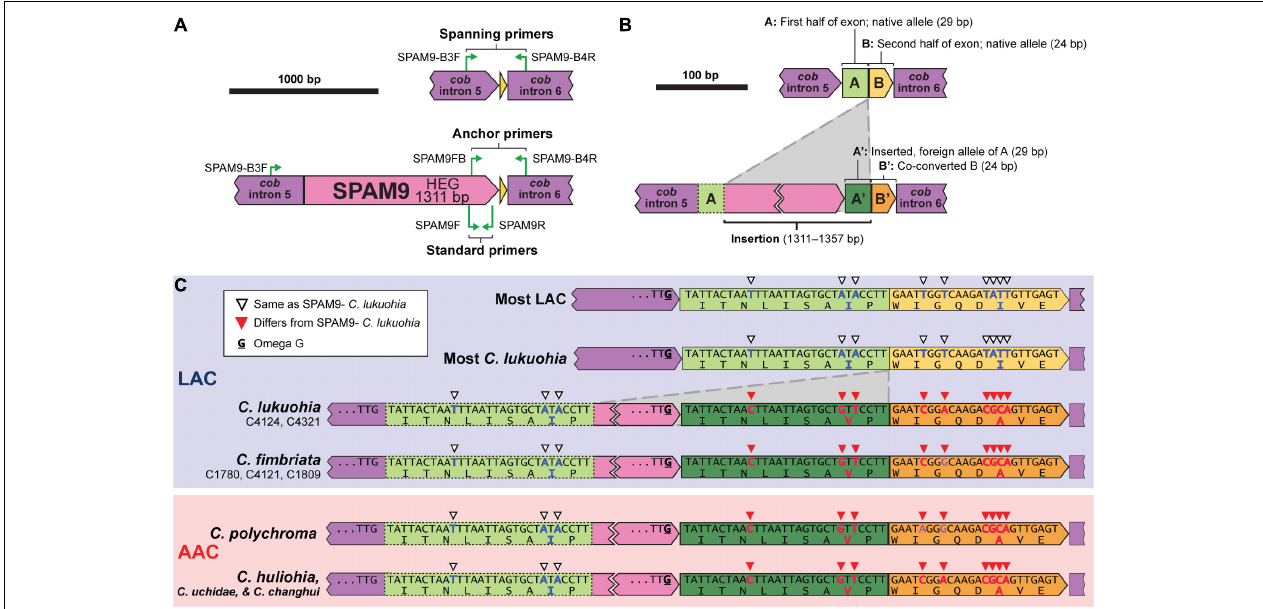
FIGURE 6 | Location, insertion, and co-conversion of SPAM9. (A) Proposed arrangements of SPAM9-negative (top) and SPAM9-positive (bottom) alleles of cob in C. lukuohia . (B) Proposed insertion scheme for SPAM9. The cob exon is split by the insertion into two regions: “A,” 29 bp, and “B,” 24 bp. SPAM9 is an autonomous homing endonuclease with a slightly different copy of A (A (cid:48) ) on its 3 (cid:48) end; it inserts in the middle of the exon, splitting A and B, and in doing so co-converts B to B (cid:48) . (C) Observed arrangements of SPAM9 and SPAM9 orthologs in sequenced genomes, with color coding as in panel (B) . Full nucleotide sequences and amino acid translations are shown for exon components A and B (green and yellow). Nucleotides and amino acids that match the sequence of C. huliohia but not SPAM9-negative C. lukuohia are marked by filled red triangles and written with red bolded letters, in contrast to the open triangles and blue bolded letters that match SPAM9-negative C. lukuohia . Purple bolded bases in other SPAM9 orthologs are bases that match neither C. lukuohia nor C. huliohia . The presumed omega-G of cob intron 5 is bolded and underlined for each isolate.